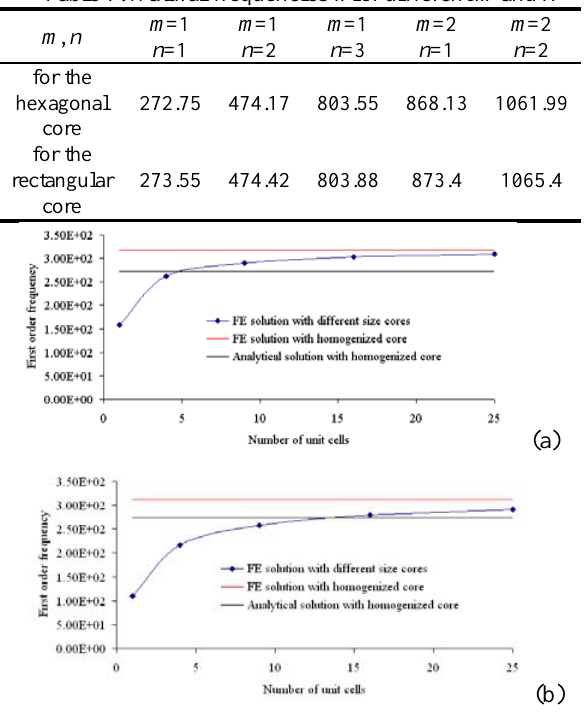
Table 7. Natural frequencies with different m an